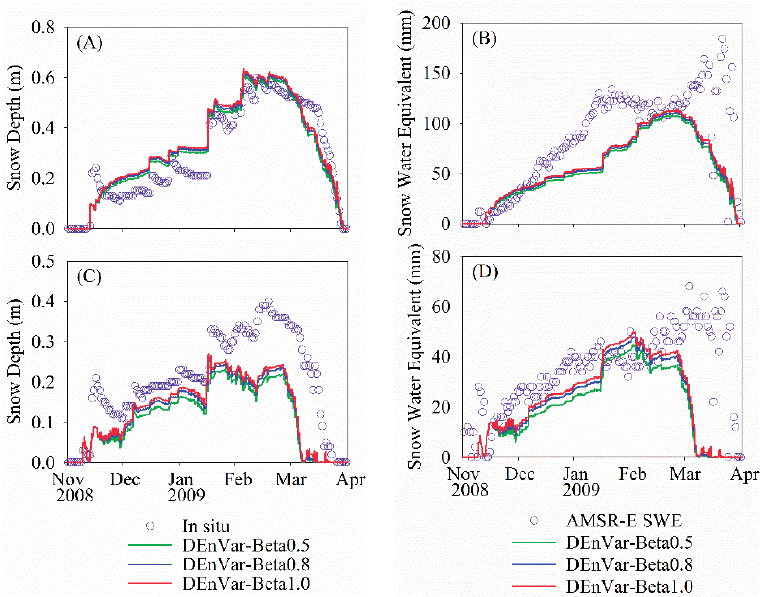
Figure 7. The time series comparison of CoLM snow states (Left: SD, Right: SWE) from snow observations and the assimilated results in DEnVar-Beta 0.5, DEnVar-Beta 0.8, and